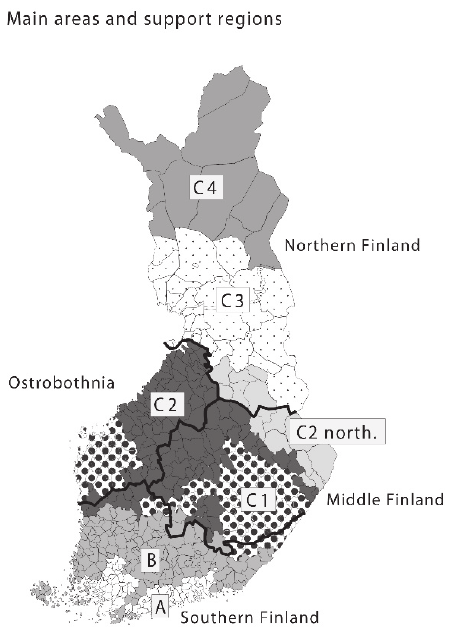
Fig. 1. Spatial aggregation of the DREMFIA sector model. The 4 main regions are divided into support regions (A, B, C1, C2, C2 north, C3, and C4) based on agricultural policy: Southern Finland – support regions A, B, C1, and C2; Middle Finland – B, C1, C2, C2 north; Ostrobothnia – C1 and C2; Northern Finland – C2 north, C3, and